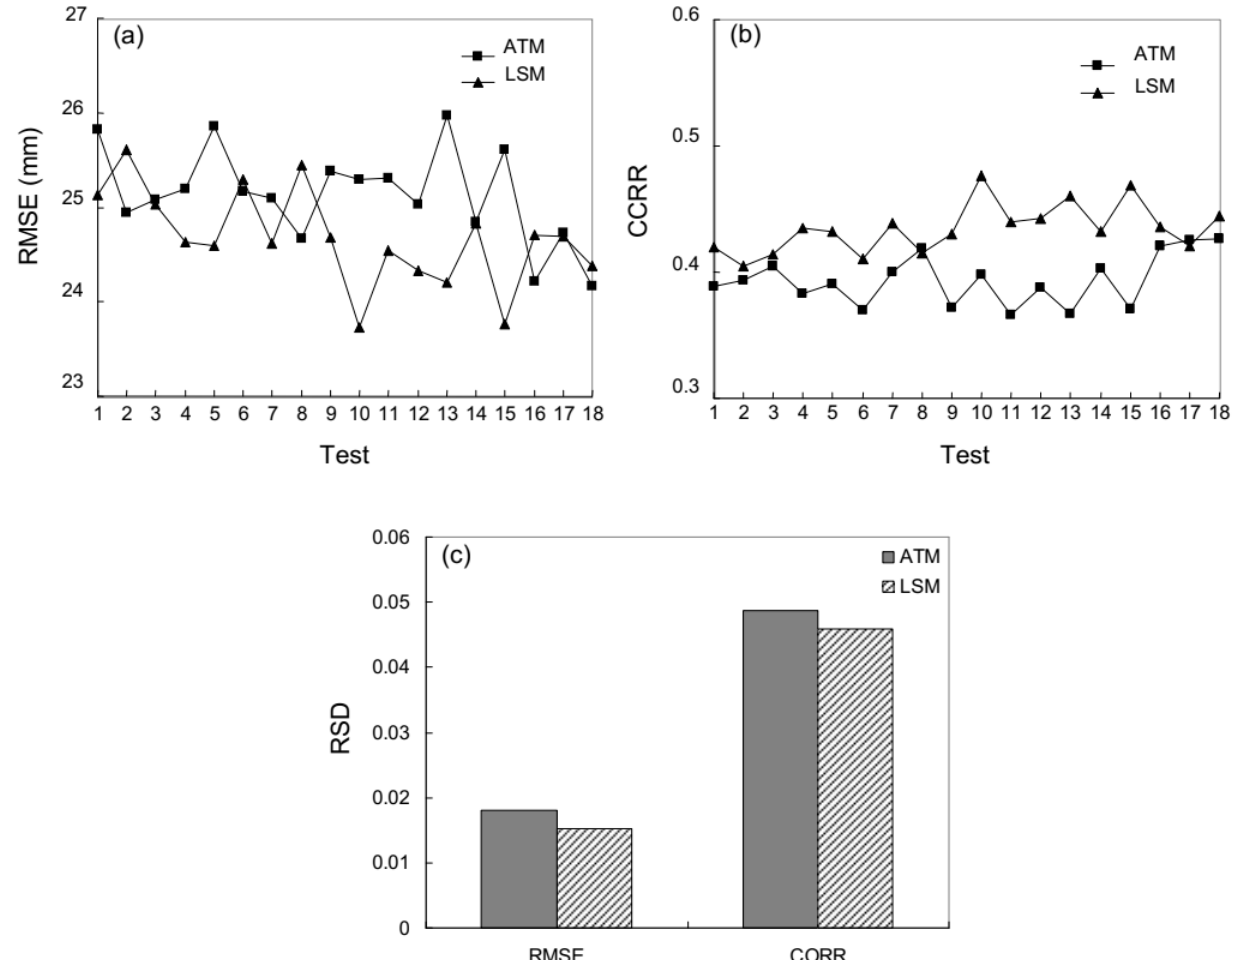
Figure 8. RMSE, CORR, and RSD of the 24-h cumulative precipitation of the ensemble forecast (Test No. 18 represents the average of the subset). ( a ) RMSE, ( b ) CORR, ( c ) RSD.